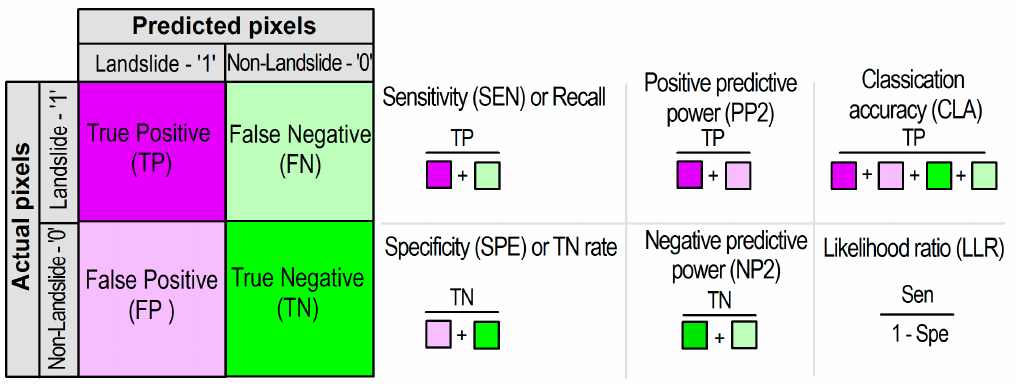
Figure 6. Confusion matrix and model measures used in this research.